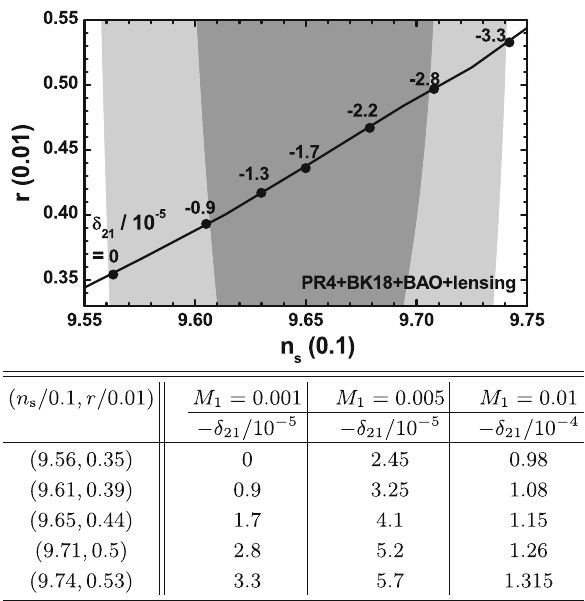
Fig. 3 Allowedcurveinthe n s − r planefor δ EMwith M 1 = 0 . 001and various δ 21 ’s indicated on the line. The marginalized joint 68% [95%] c.l. regions [40] from PR4, BK18 , BAO and lensing data-sets [39] are depictedbythedark[light]shadedcontours.Theallowedcurveremains essentially unaltered if we set M 1 = 0 . 005 or 0 . 01. The variation some of the δ 21 values indicated in the plot is shown in the